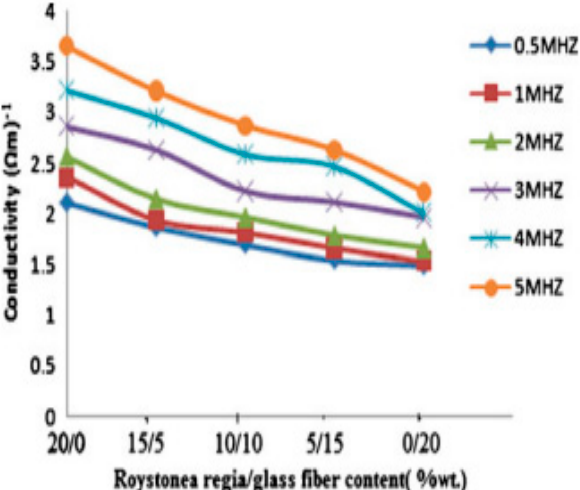
Figure 6. The electrical conductivity of hybrid fiber epoxy composites [148] (Reprinted/adapted with permission from Elsevier Ref.5457271065453 Copyright 2012.).